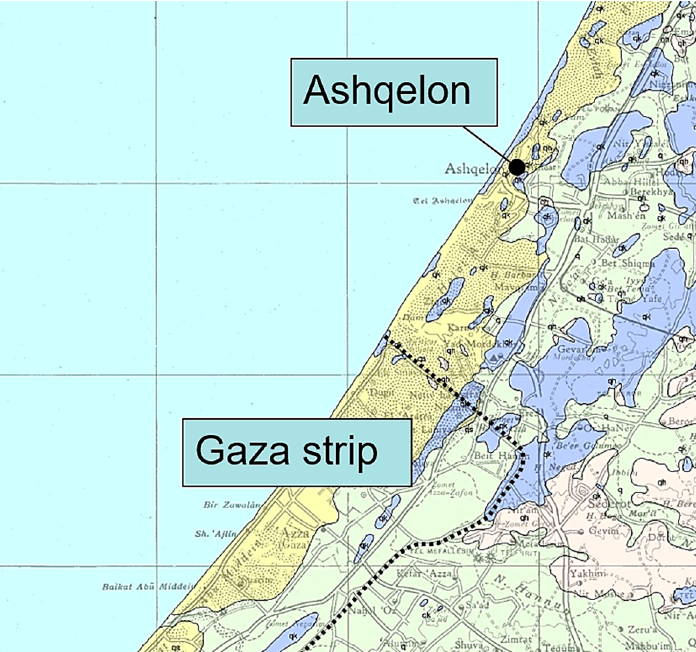
Figure 2. Geological map of southern Israel and the Gaza Strip (modified from [22]).